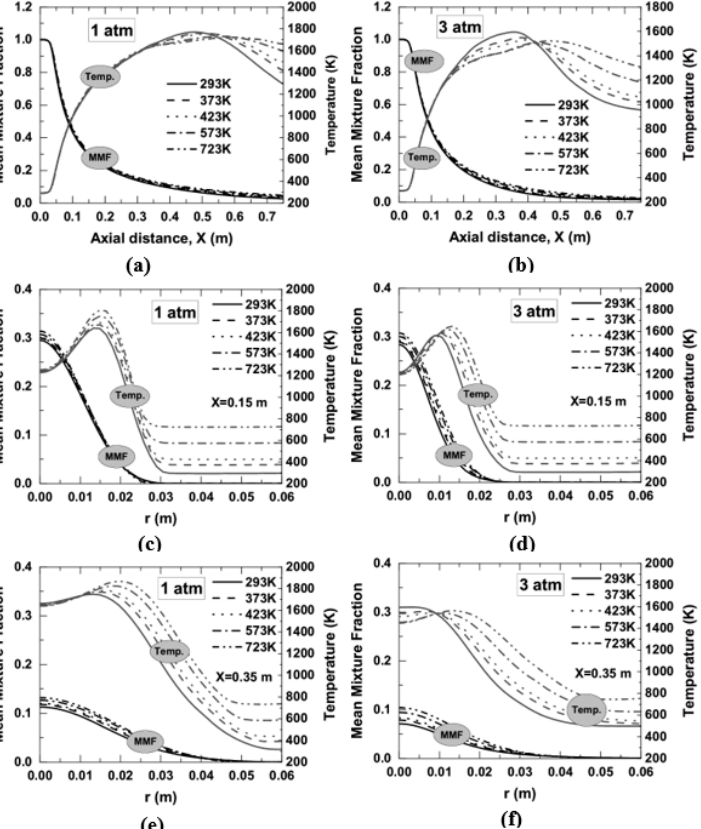
Figure 16 . Temperature profile obtained as a function of air temperature at 1 and 3 atm; ( a , b ) along the centerline, ( c , d ) radial variation of temperature at an axial location of 0.15 m, and ( e , f ) radial variation of temperature at an axial location of 0.35 m.